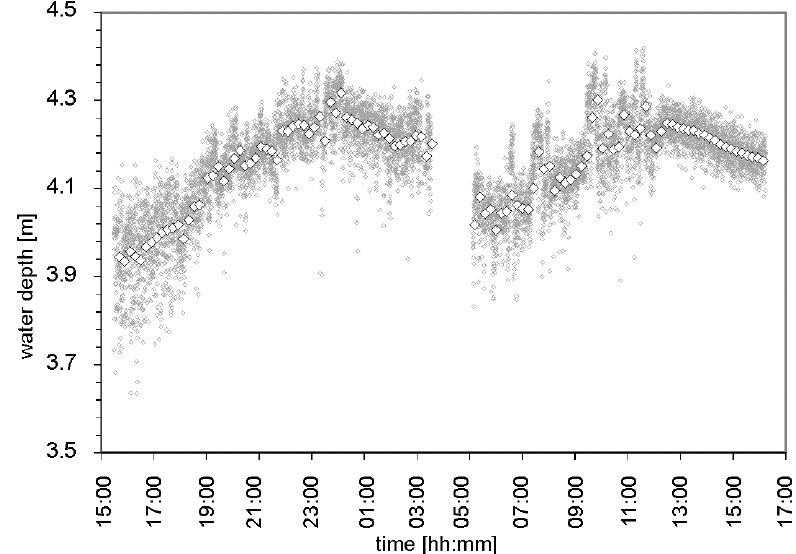
Figure 4. Water column height over the Cabbé submarine spring ( i.e. , water depth) in 20 min intervals (white diamonds); grey points display individual 10 second